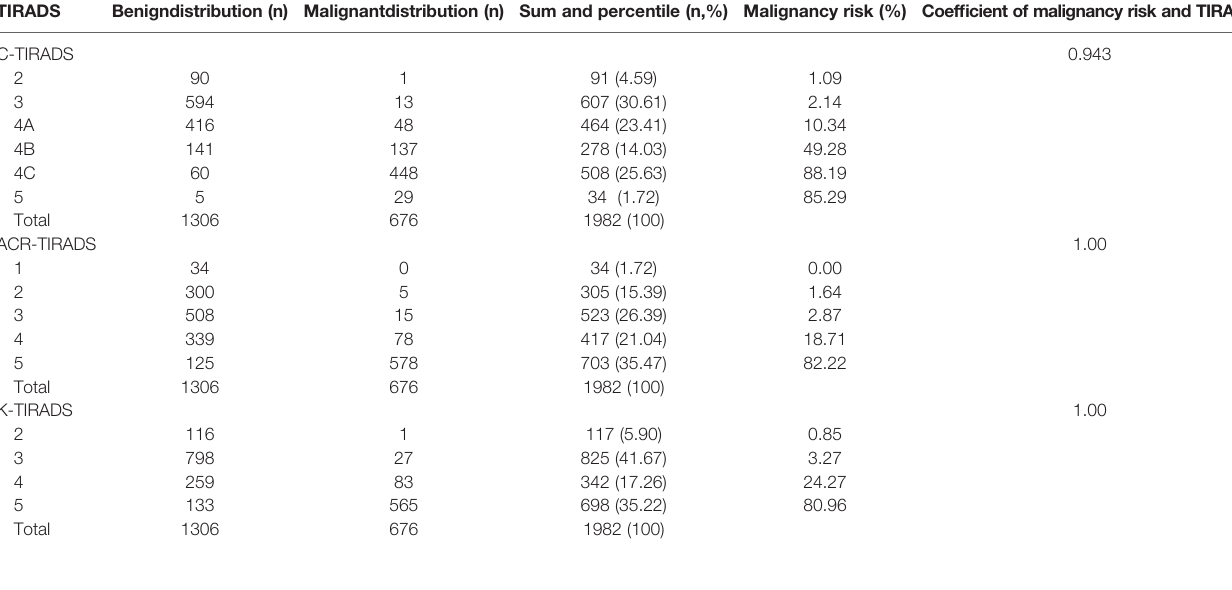
TABLE 3 | Distributions of benign and malignant nodules in different categories of TIRADSs and correlations. TIRADS C-TIRADS